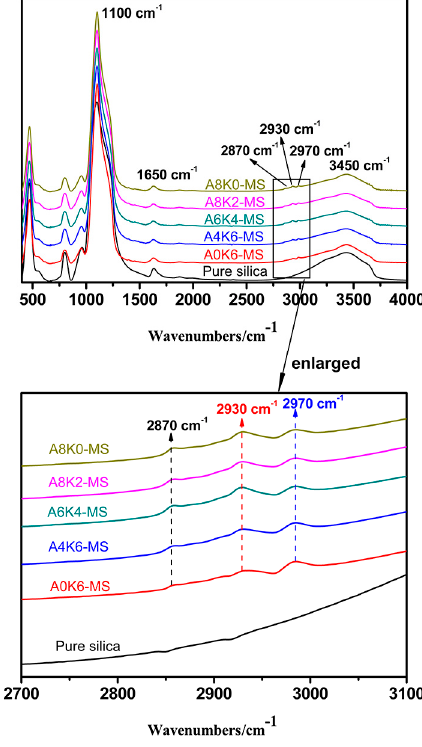
Figure 2. Fourier transform infrared (FT-IR) spectra of pure silica and all modified silica.